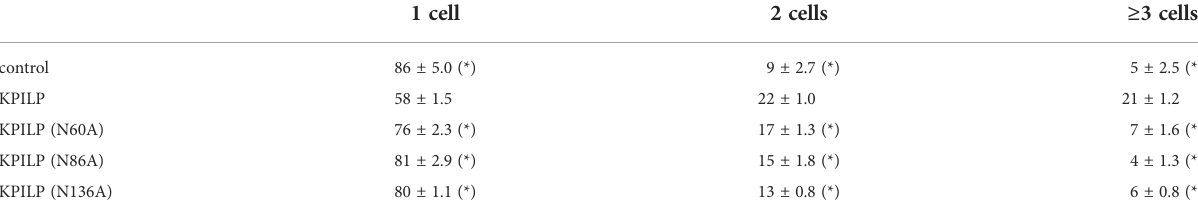
TABLE 1 Quanti fi cation of 2×GFP intercellular movement # in presence of 35S-KPILP or its mutant variants. 1 cell 2 cells